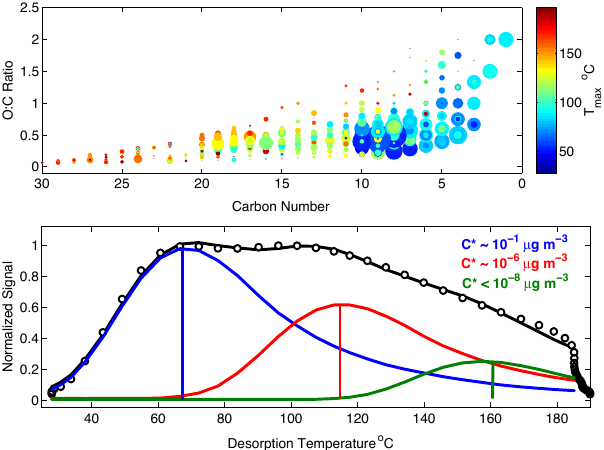
Figure 5. Top: points are plotted sized by the square root of their particle-phase desorption signal. Evident is a secondary mode in abundance space between carbon number 15 and 20. Each com- pound is colored by the temperature of maximum desorption sig- nal, which is related to a compound’s enthalpy of sublimation (sat- uration vapor pressure) as shown previously (Lopez-Hilfiker et al., 2014). Bottom: a sum thermogram, i.e., the entire mass spectral sig- nal at each measurement time (using selection criteria detailed in the text), is summed and plotted versus desorption temperature. Clearly SOA from α -pinene ozonolysis exhibits multiple modes. The first mode is consistent with monoterpene-derived diacids, whereas the secondary modes which arise at temperatures >100 ◦ C have effec- tive vapor pressures at least 4 orders of magnitude lower than com- mon monoterpene oxidation